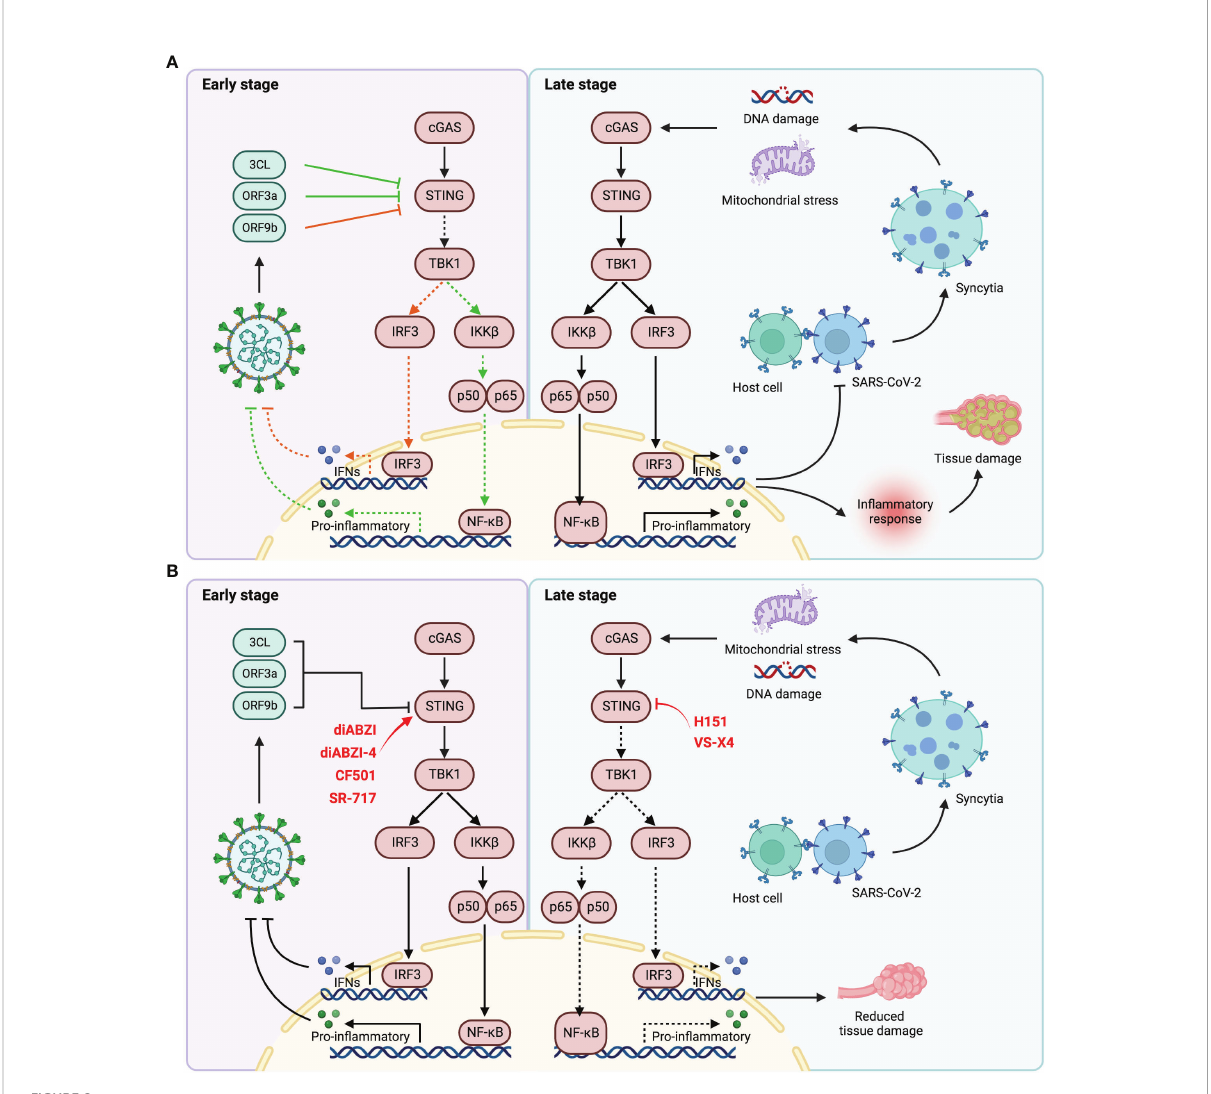
FIGURE 2 The relationship of SARS-CoV-2 infection and STING pathway. (A) At the early stage of SARS-CoV-2 infection, the viral proteins inhibited the activation of STING pathway by direct interaction with STING (left). During the late stage of infection, the host cells fused with virus through the interaction of ACE2 and S protein to form syncytia, which contains a large number of micronuclei, mediating DNA damage and thus activating STING signaling. Durable and excessive STING activation lead to abnormal in fl ammatory response, resulting in tissue damage and poor prognosis (right). (B) STING agonists could be used to activate STING signaling at the early stage of infection to elicit anti-viral response (left). STING inhibitors could attenuate tissue damage by suppressing excessive STING activation and aberrant in fl ammatory response